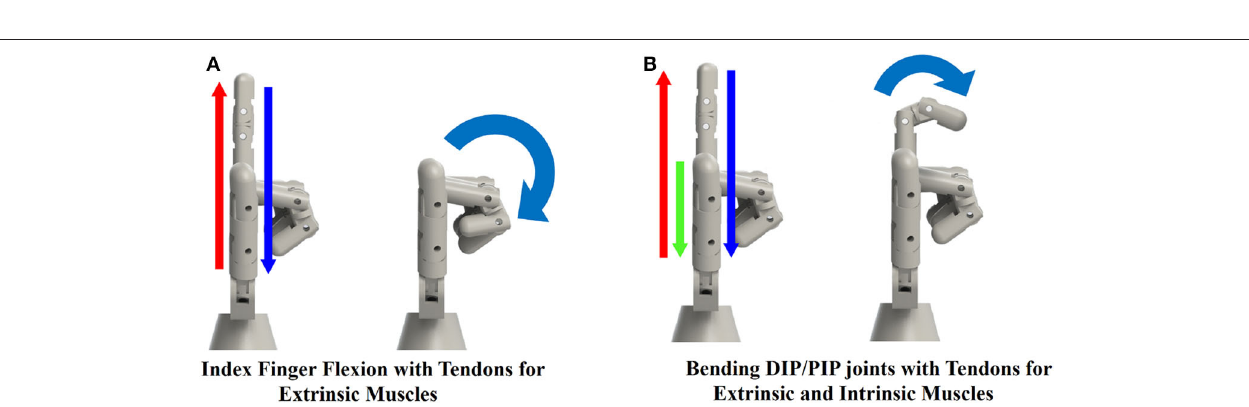
FIGURE 5 | Side view of two different index finger motions. (A) Flexion of index finger by pulling the wire on the glove only. All three finger joints bends. (B) Flexion of index finger’s PIP and DIP joints by pulling the extensor tendon inside, and the flexion tendon on the